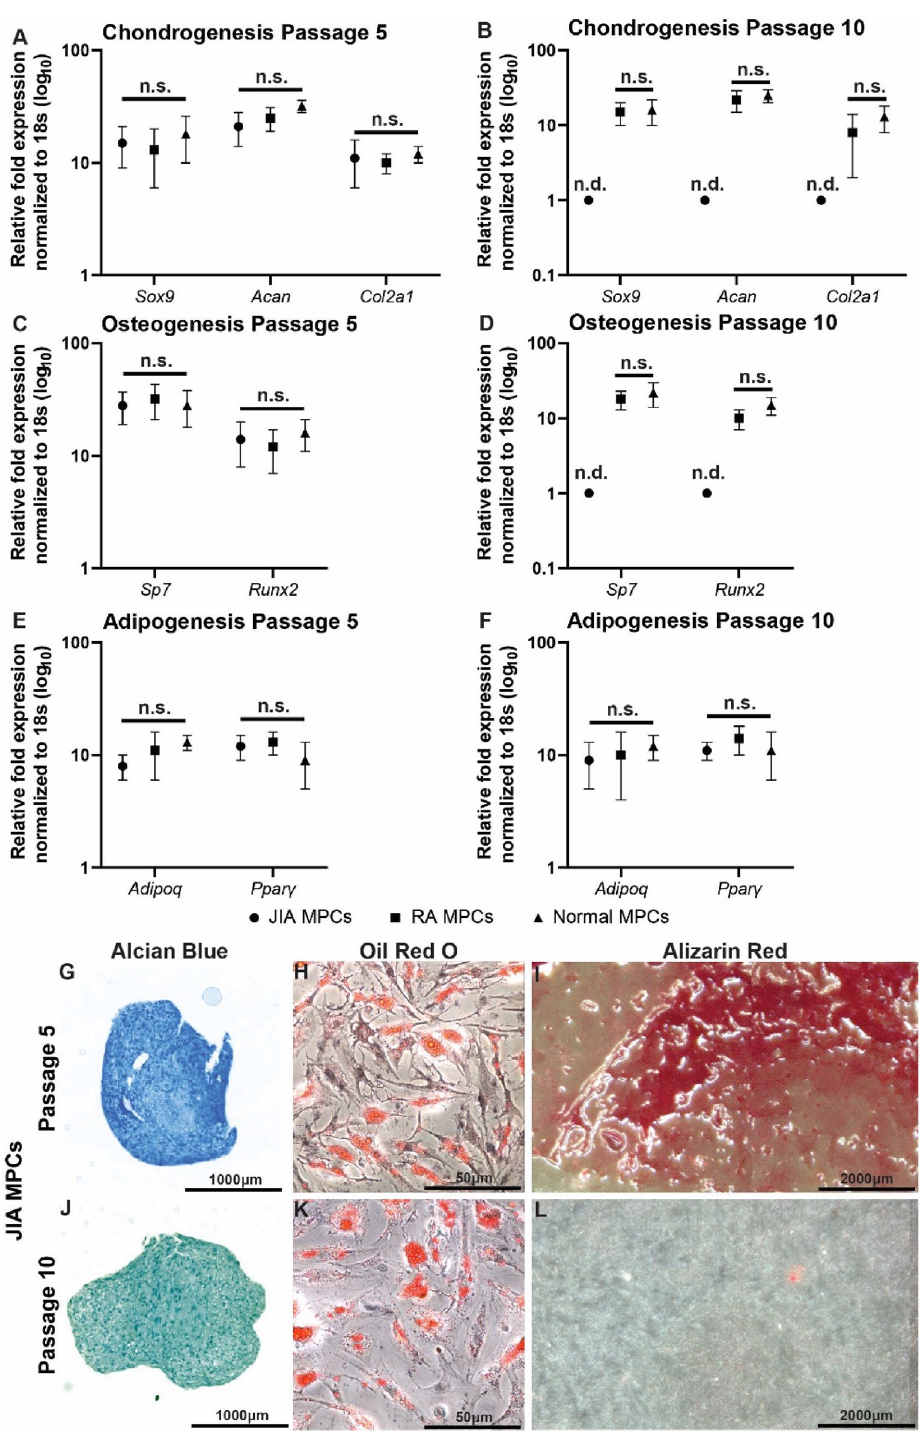
Figure 5. MPC differentiation potential. Synovial MPCs from normal (n = 5), JIA (n = 19) and RA (n = 5) joints were assayed for chondro-( A , B ), osteo-( C , D ) and adipogenic ( E , F ) differentiation capacity at passage 5 ( A , C , E ) and passage 10 ( B , D , F ) Differentiation was validated through the use of histological assessment of Alican Blue ( G , J ), Oil Red O ( H , K ) and Alizarin Red ( I , L ) in JIA MPCS at passage 5 ( G - I ) and passage 10 ( J - L ). n.s = not significant, n.d = not detected. Error bars represent mean + /-